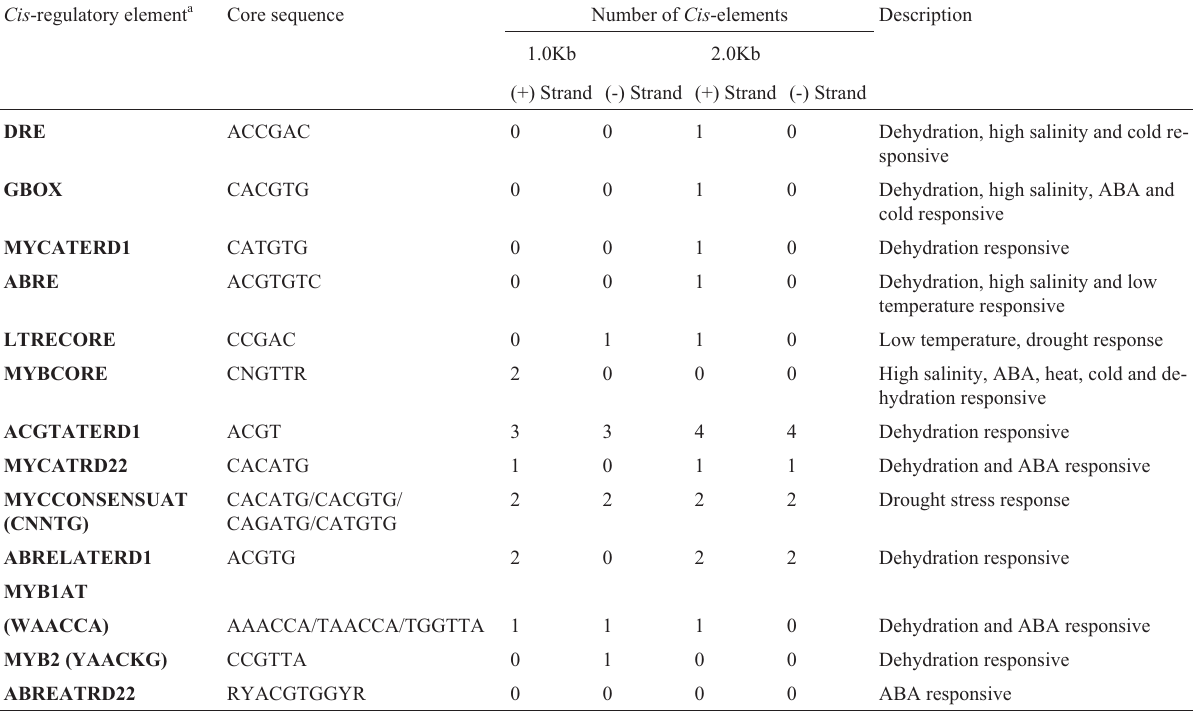
Table 1 - Cis -elements responsive to drought stress in the pGAL soybean promoter. Cis -regulatory element